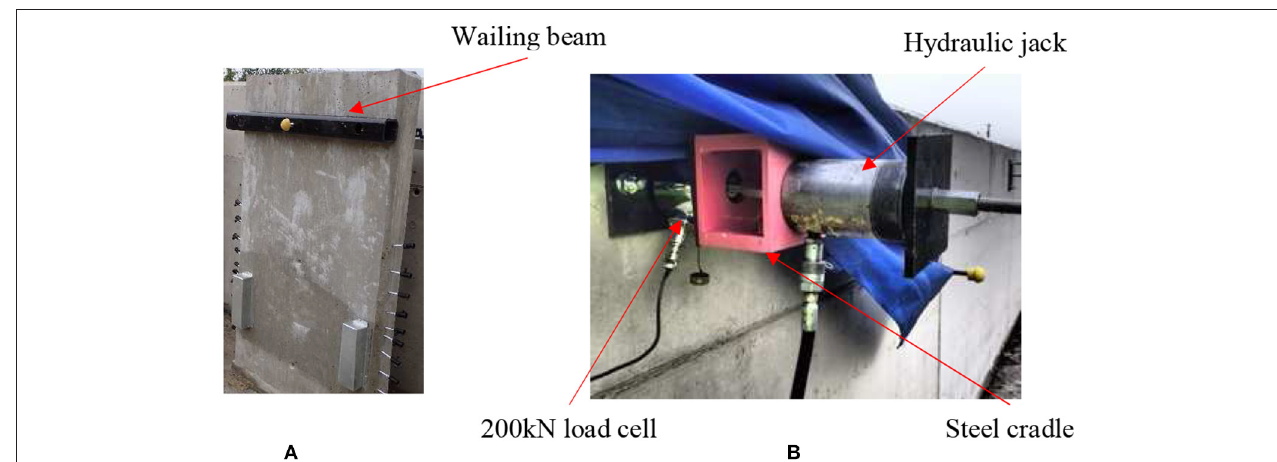
FIGURE 9 | Loading arrangement (A) Front face of trial panel (B) Rear face of reaction